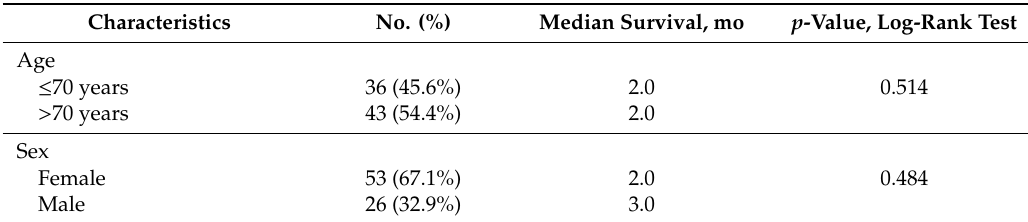
Table 1. Clinicopathological